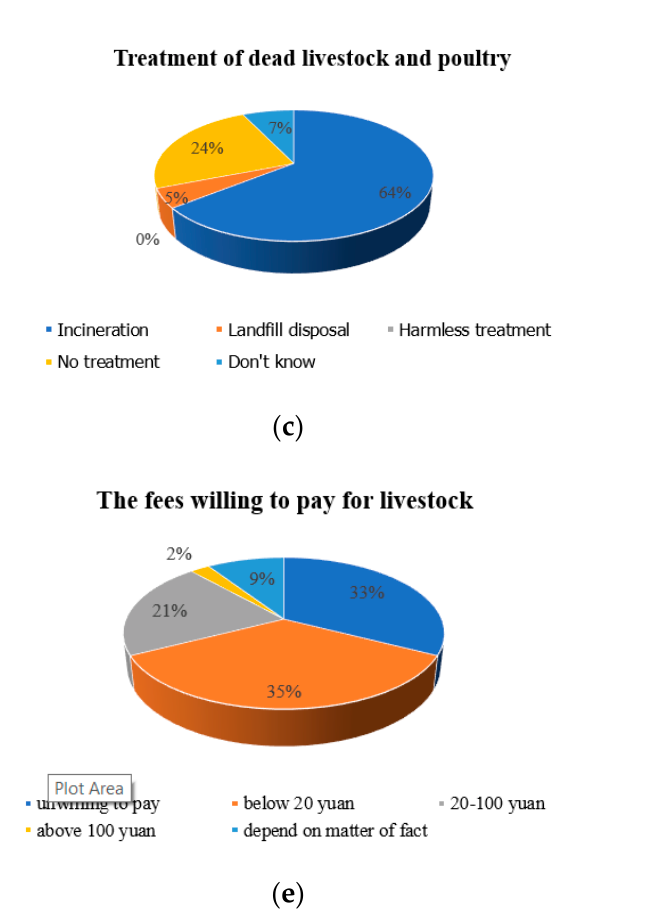
Figure 2. Questionnaire statistical results;( a ) The main processing method for excrements. ( b ) Fecal reduction technique. ( c ) Processing for the dead livestock. ( d ) How familiar the farmers with livestock control. ( e ) The fees willing to pay for livestock.